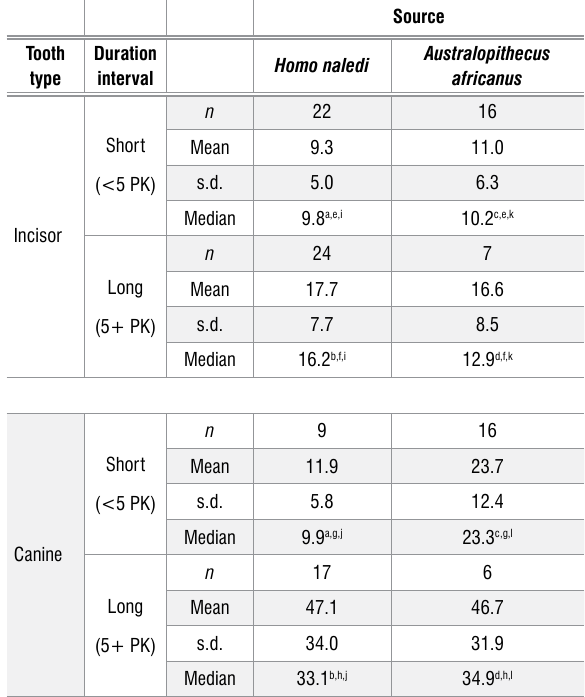
Recurrence: Number of perikymata between